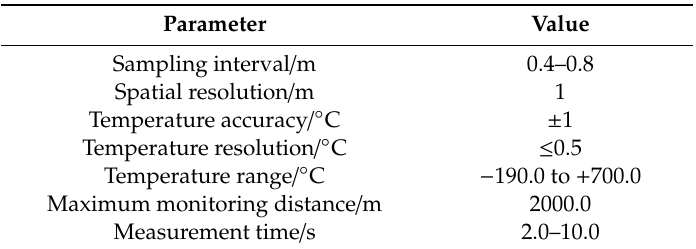
Table 4. ROTDR parameter